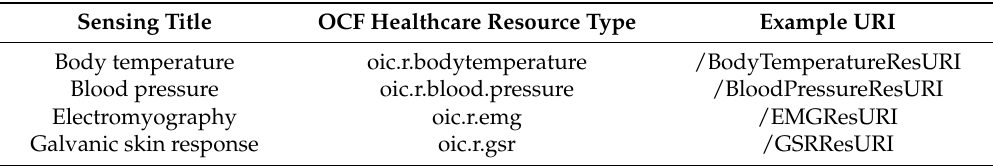
Table 1. OCF healthcare resources for e-Health services.